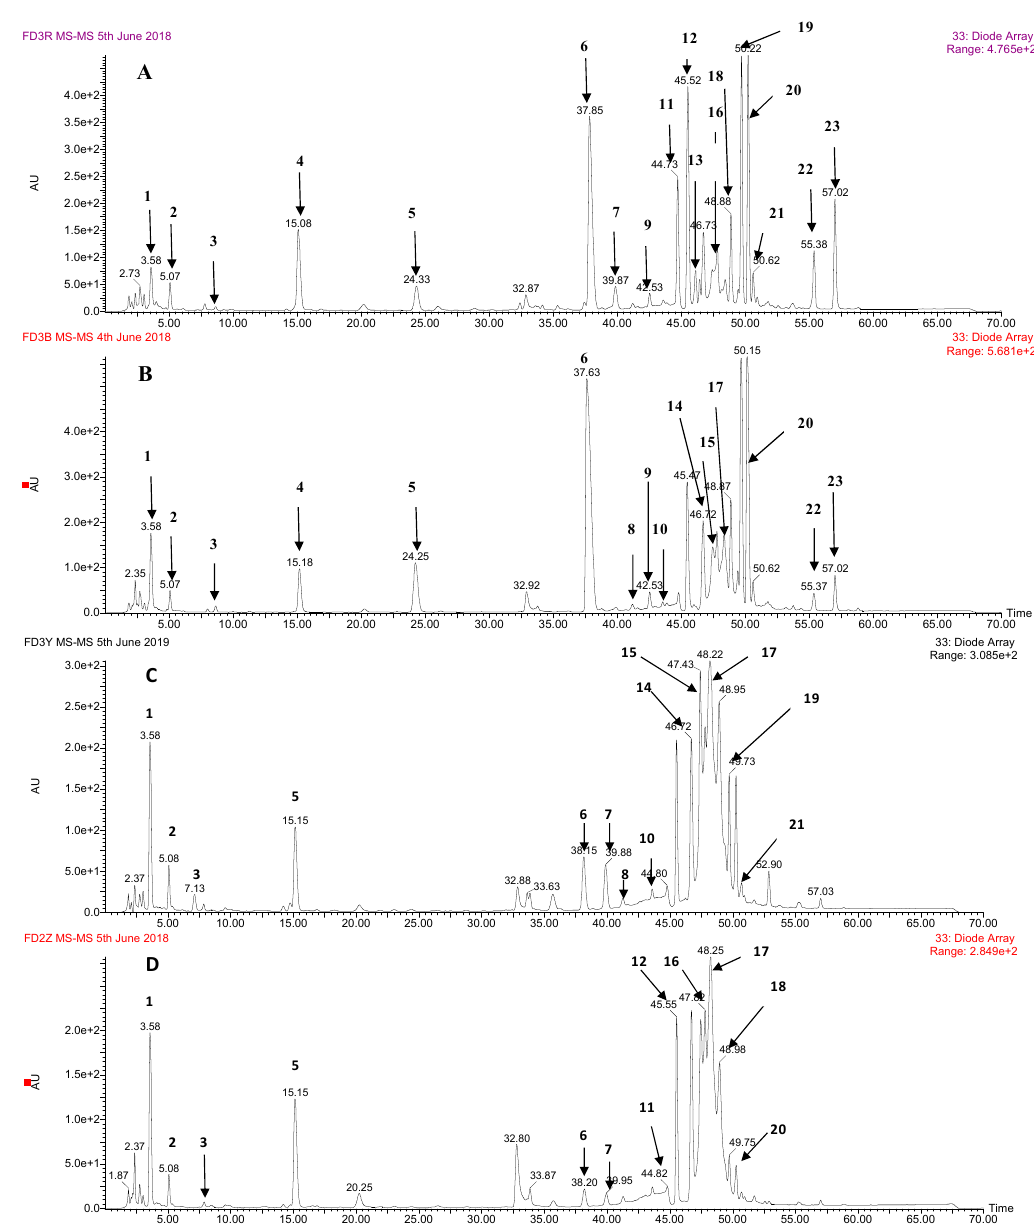
Figure 1. HPLC chromatogram of phenolics from petal ( A ), stamen ( B ), calyx ( C ), and ovary ( D ) of the tree peony flower. AU: absorption unit; e + 1: 10 1 ; e + 2: 10 2 ; number 1, 2, 3, 4, . . . , 20, 21 corresponds to No. 1, 2, 3, 4, . . . , 20, 21 listed in Table 1, and 22, 23 was the unidentified compounds.